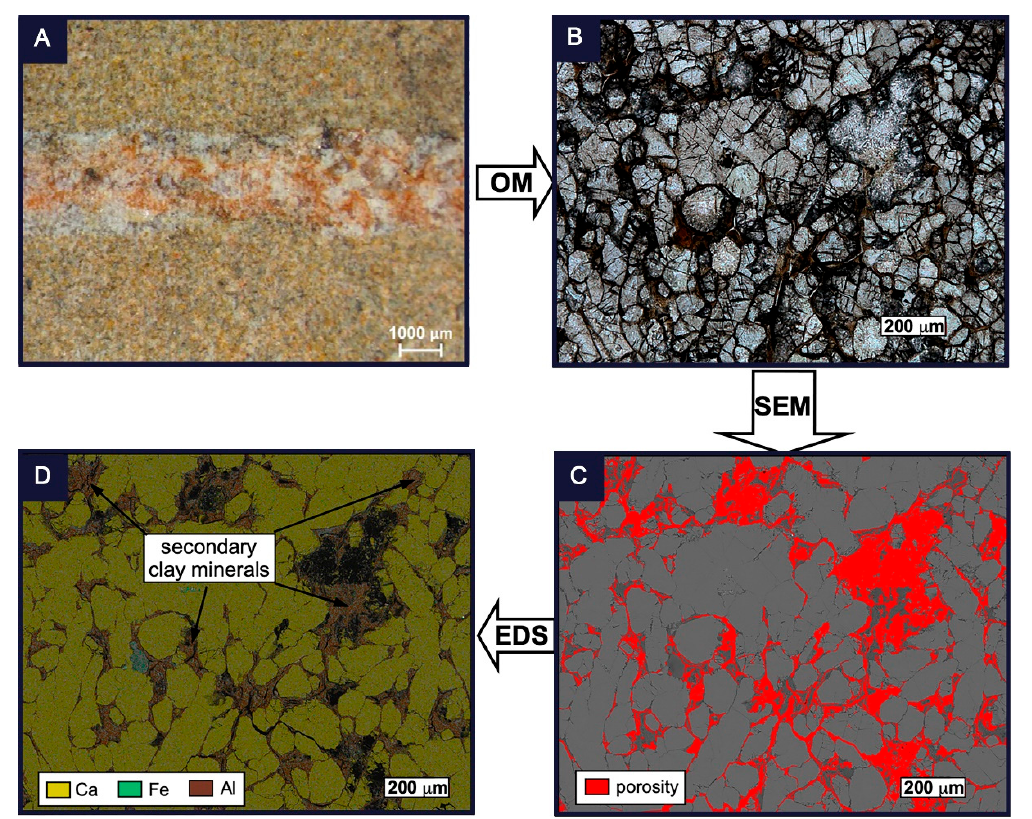
Figure 11. Observation of the petrographic and mineralogical features of a reddish carbonate filling by the combination of different analytical methodologies: ( A ) stereomicroscope; ( B ) plane polarized light OM; ( C ) backscattered electrons (BSE) SEM image reprocessed with feature identification analysis software to quantify and map the sample porosity; and ( D ) EDS map showing the distribution of Ca, Fe, and Al.